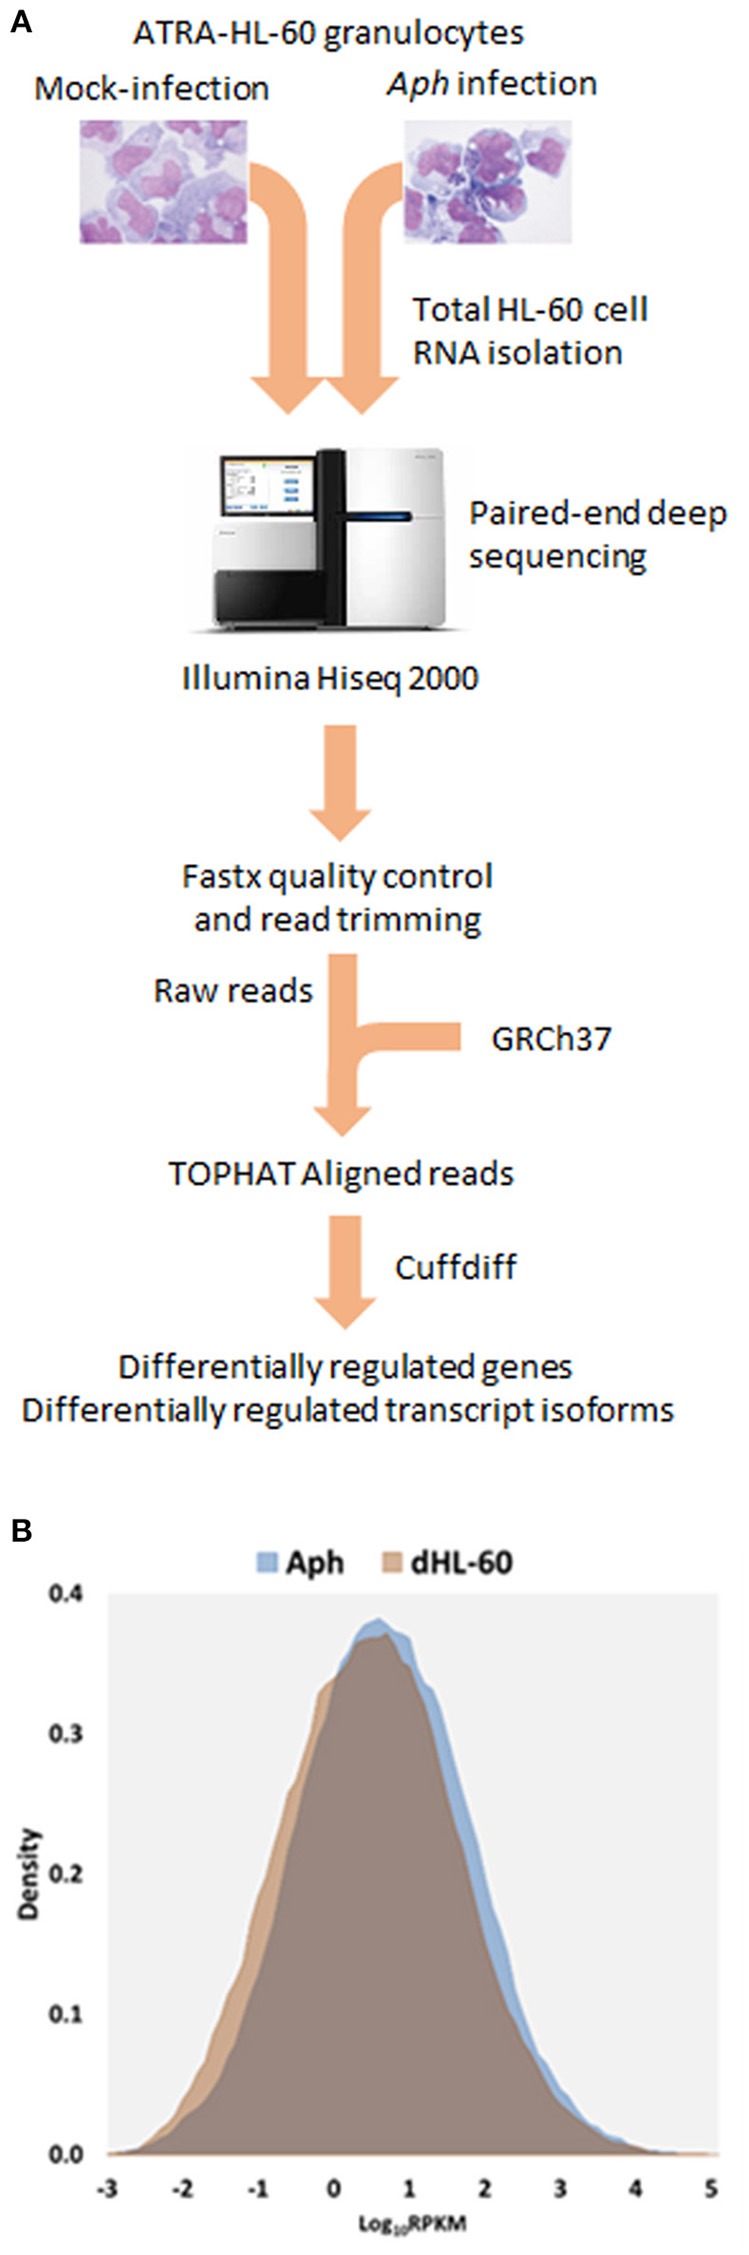
(A) Flow-chart of the RNAseq experiments. A. phagocytophilum-infected and uninfected ATRA differentiated HL-60 granulocytes were propagated for 5 days until heavily infected; total host RNA was isolated and sent for RNAseq, and then raw reads were assembled after RNAseq, to obtain RPMK (gene level analyses) and FPMK (transcript-level analyses). (B) Density plots overlaying distribution of gene level RPKM in A. phagocytophilum infected and uninfected ATRA-differentiated HL-60 cells. Note the marked increase in overall gene-level transcript quantities, as noted by a shift in the density plot.